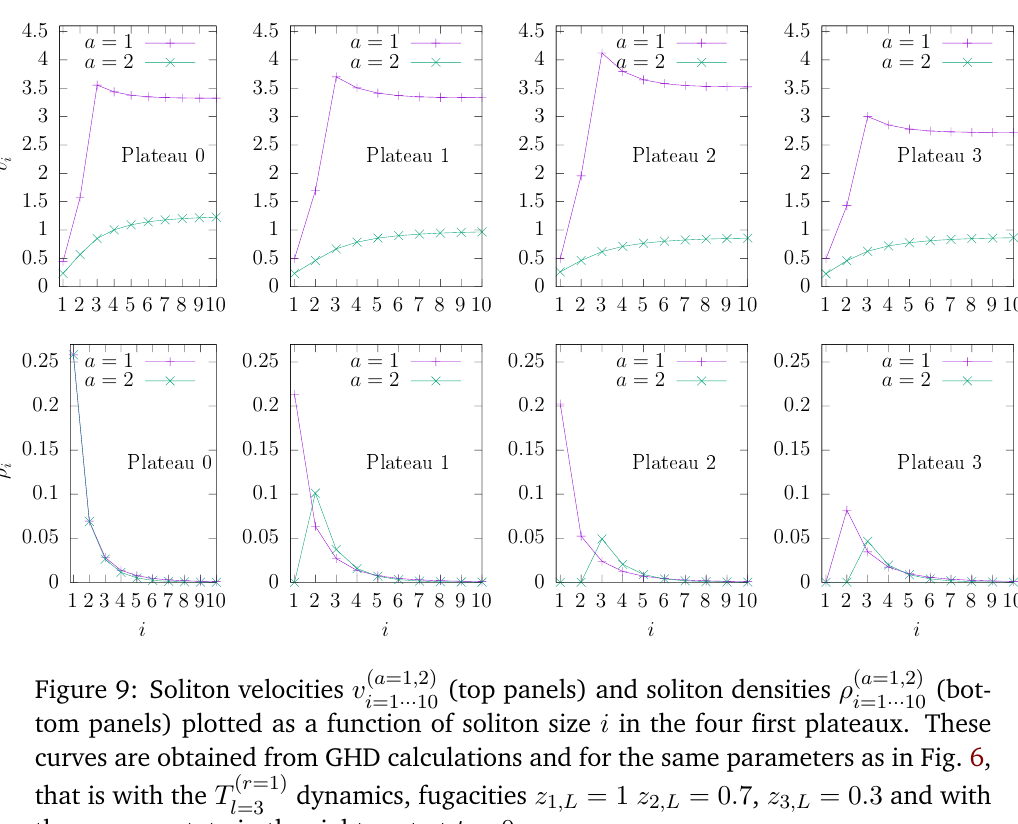
( a =1 , 2) (bot- i =1 ··· 10